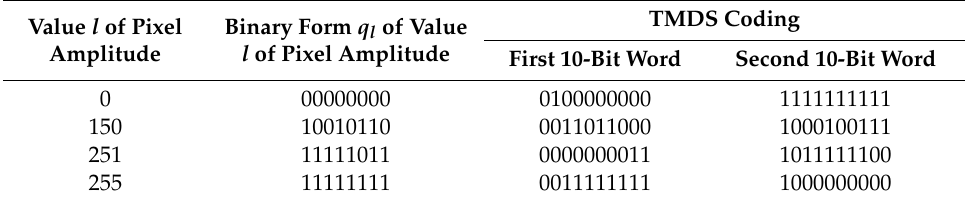
Table 1. Examples of TMDS (transition minimized differential signaling) coding of pixel amplitude